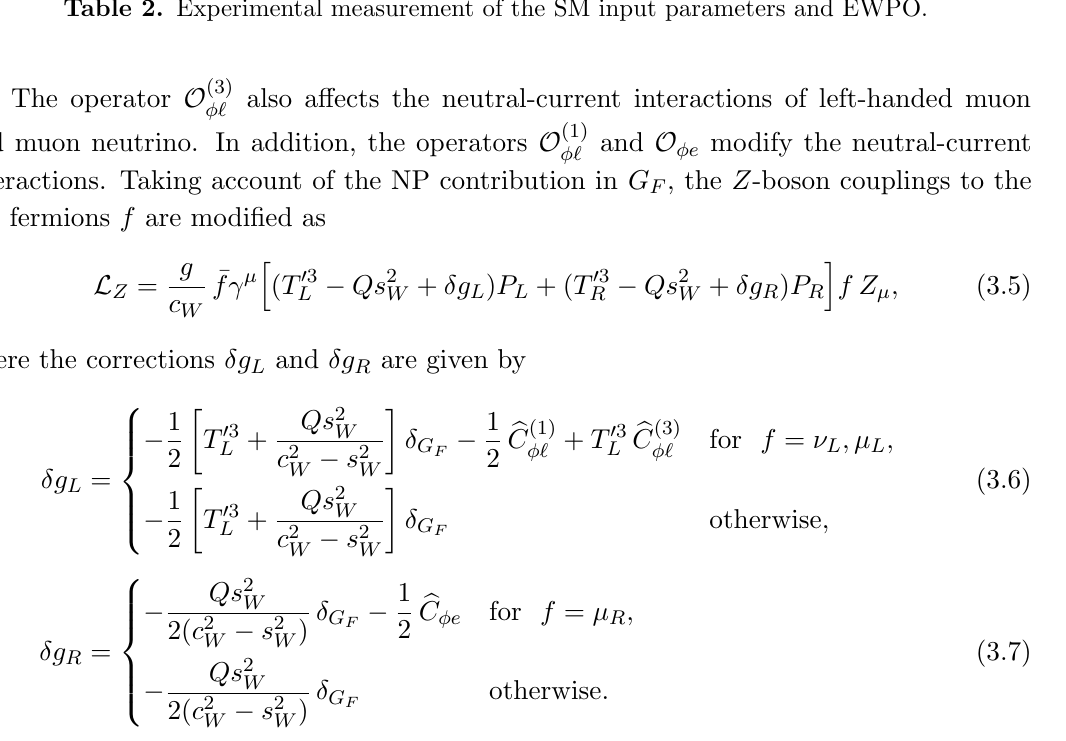
Table 2. Experimental measurement of the SM input parameters and